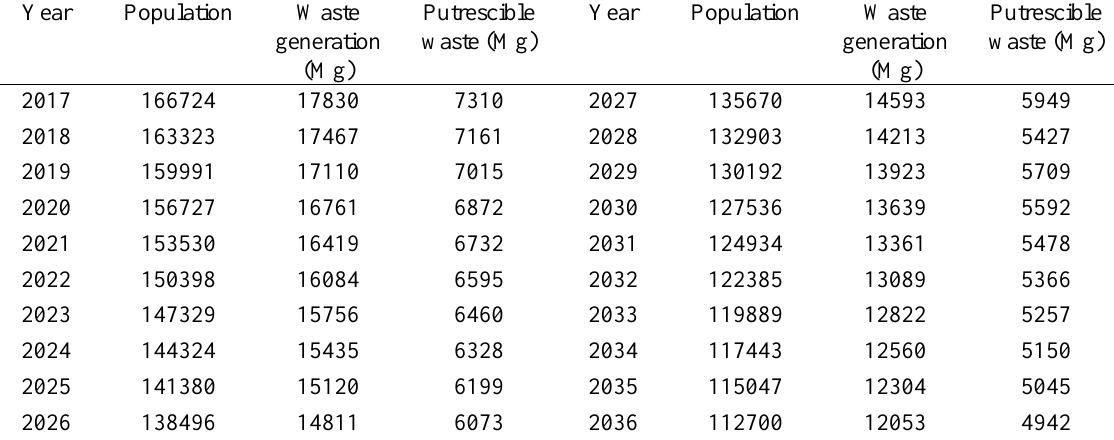
Table 3. The population and amount of waste generated in the period 2016-2036